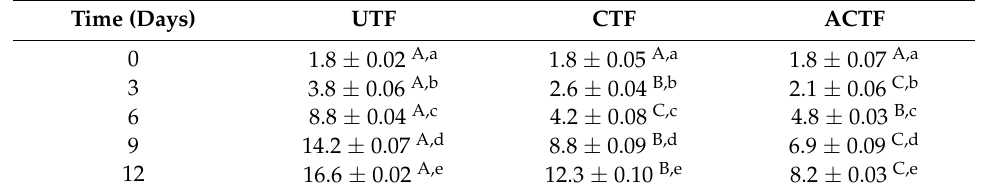
Table 1. Peroxide (meq kg − 1 ) values in uncoated and coated trout fillets during refrigerated storage at 4 ◦ C for 12 days*. UTF = uncoated; CTF = carrageenan coated; ACTF = carrageenan coated with ELO.